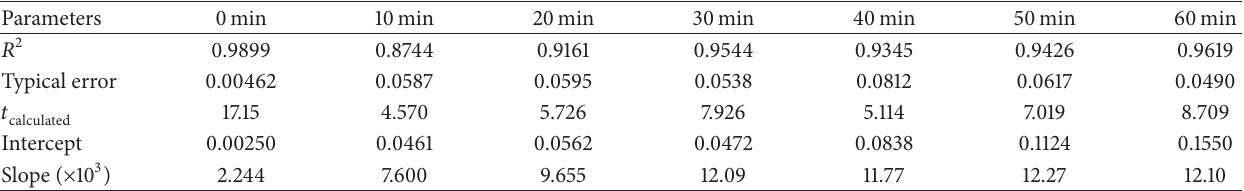
Table 2: Calibration curves and statistical parameters for different fixed times at 50 ∘ C, monitoring at 610 nm and AOF concentration ranging between 6.0 × 10 −6 and 3.0 × 10 −5 mol L −1 .